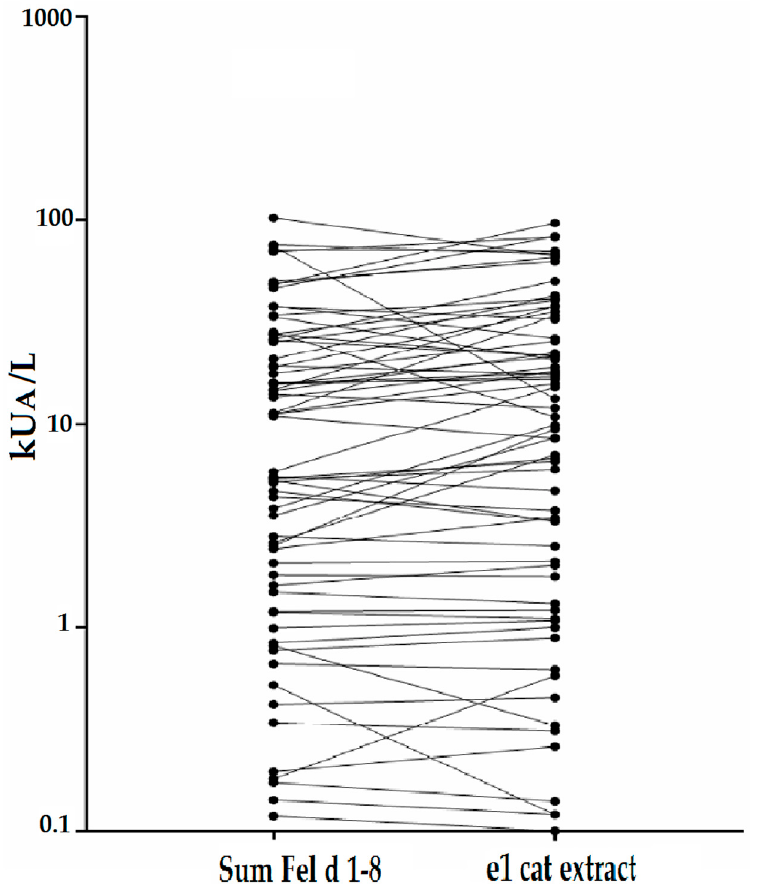
Figure 2. Correlation between the cumulative sum of Fel d 1–Fel d 8-specific IgE antibody levels and IgE levels to the cat allergen extract. Pearson’s correlation coefficient r = 0.822 ( p < 0.01).